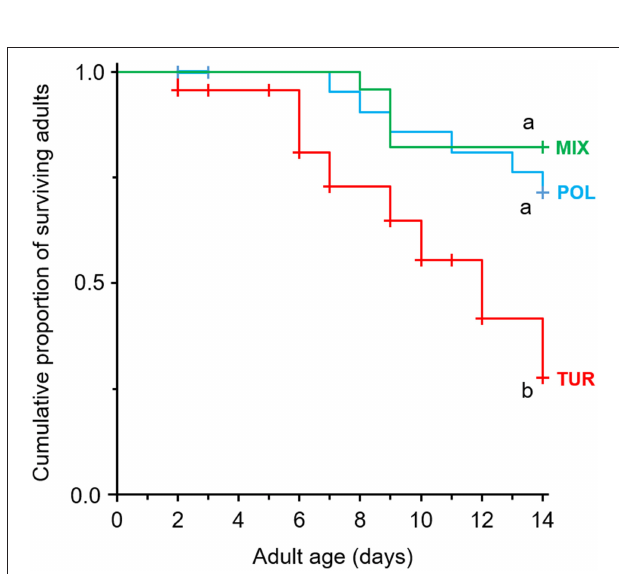
FIGURE 1 | adulthood, (B) percentage of dispersing mites per leaf disc, and (C) developmental time in the different diets (each box plot horizontal line shows the median, upper and lower box boundaries the quartiles, and whiskers the extreme values within a category). Significant differences between treatments are indicated by asterisks; A-B : χ 2 -test; (C) Tukey-HSD test: P < 0.001 (***), ns, not significant.